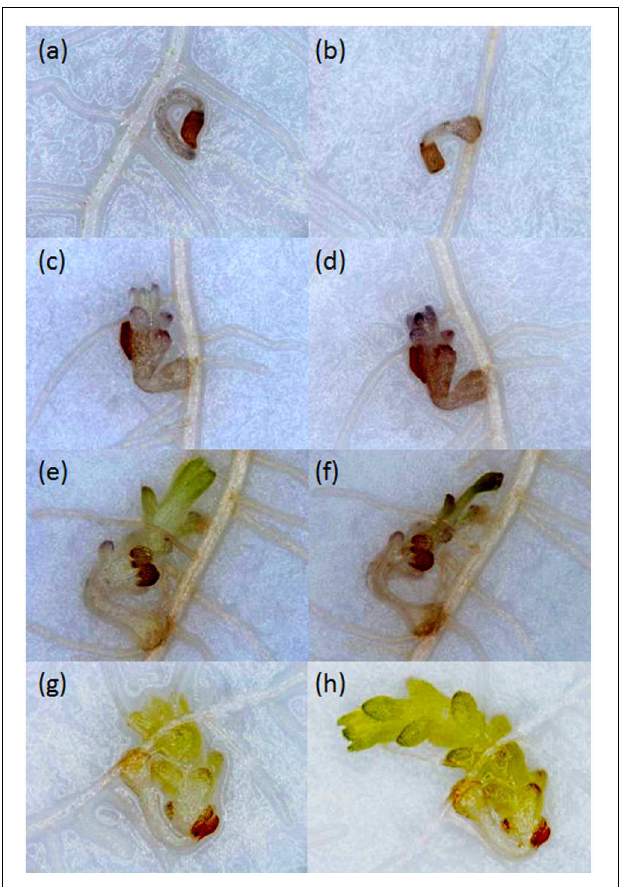
FIGURE 1 | Growth of Striga hermonthica seedlings inoculated onto rice roots in a rhizotron under 100 × magnification. (a) A seedling that failed to attach to the host root at 14 DAI. (b) A seedling that attached to the root but showed no shoot emergence at 21 DAI, or no shoot elongation from (c) 14 DAI to (d) 21 DAI. A seedling that (e) reached the four or more leaf pairs stage before 14 DAI and then (f) died before 21 DAI. A seedling that parasitized successfully with steady healthy shoot growth from (g) 14 DAI to (h) 21